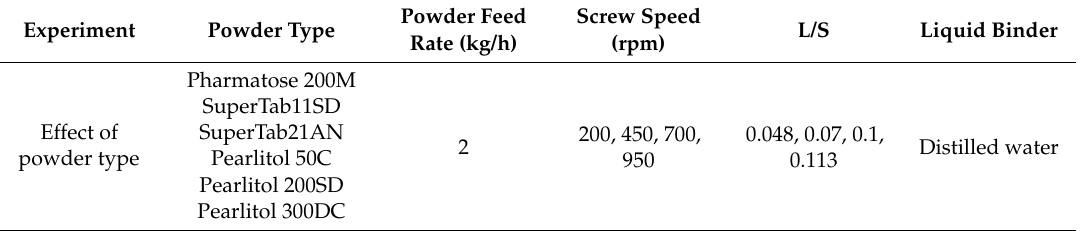
Table 1. Experimental conditions and variables used in the study. L/S : liquid to solid ratios.